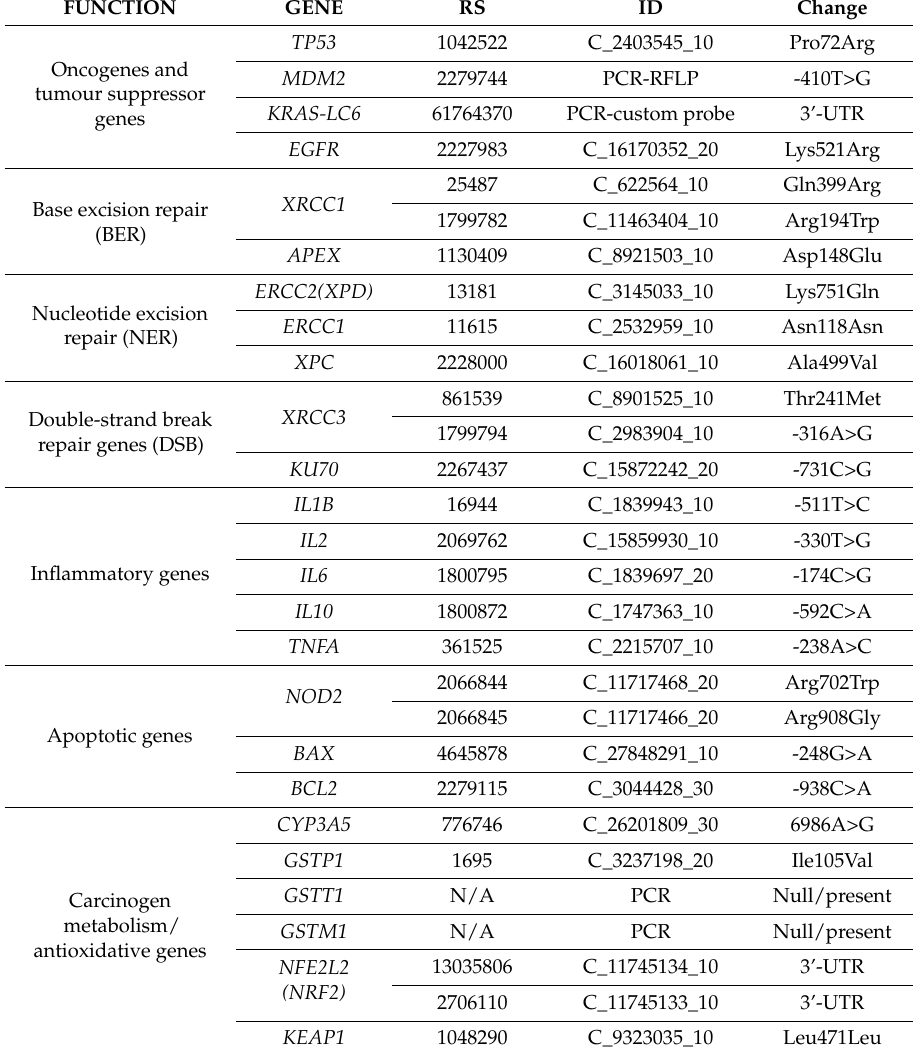
Table 5. SNPs selected in the study. Candidate SNPs were selected in oncogenes and tumour suppressor genes, DNA repair (either BER, NER and DSB), inflammatory, apoptotic and carcinogen metabolism genes, as described in Material and